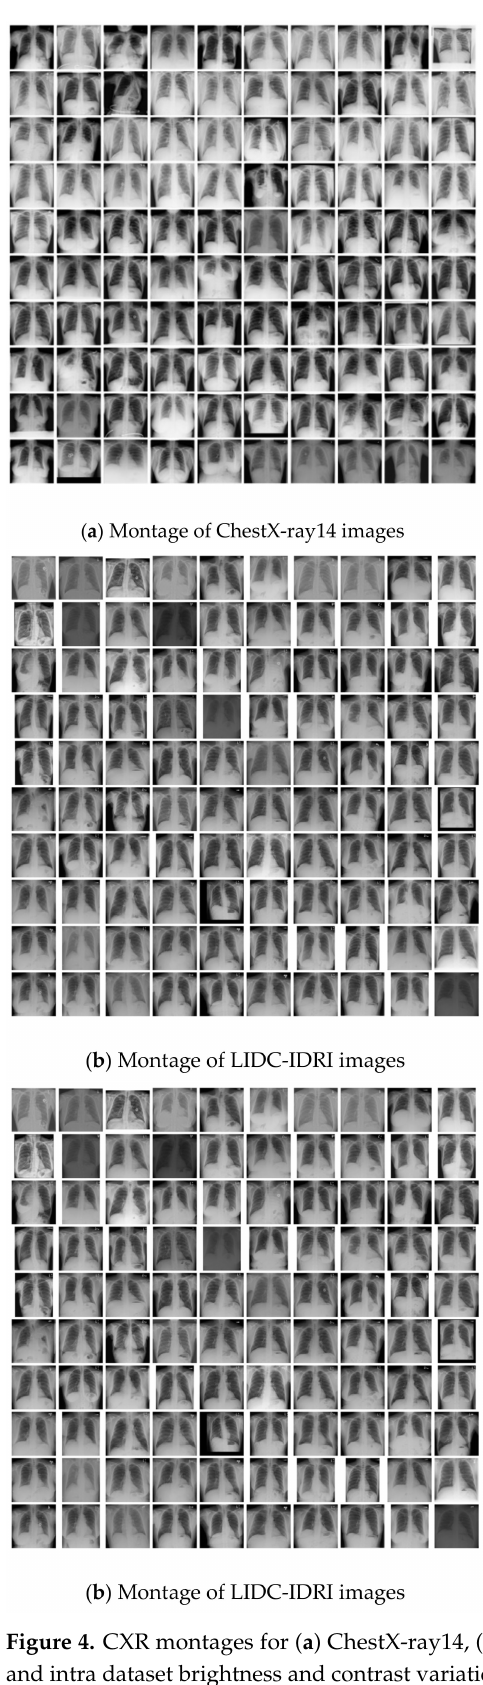
Figure 4. CXR montages for ( a ) ChestX-ray14, ( b ) LIDC-IDRI and ( c ) JSRT datasets showing inter and intra dataset brightness and contrast